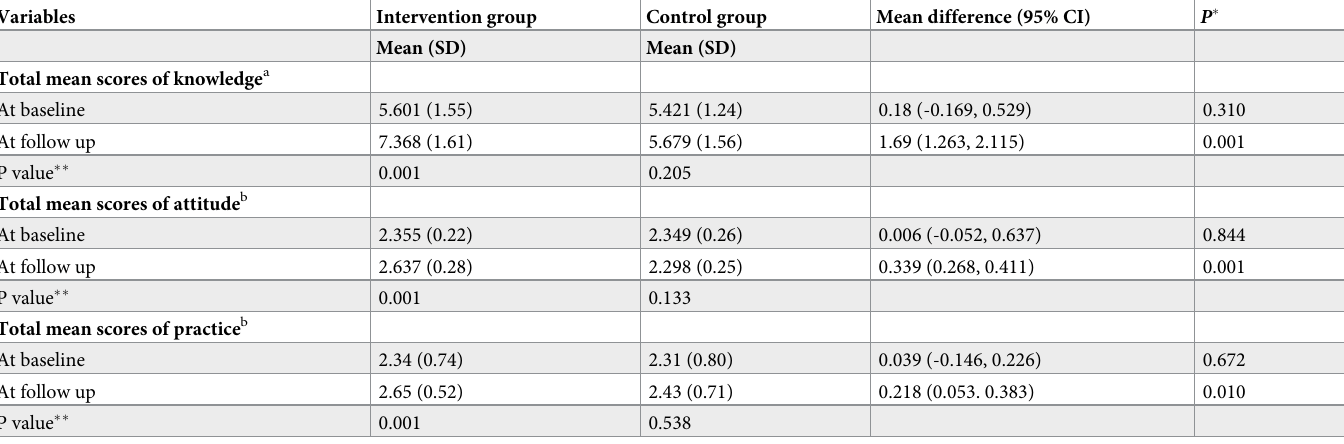
Table 3. The participants’ mean scores of knowledge, attitude and practice about head lice in intervention and control groups at baseline and at the two months fol- low-up